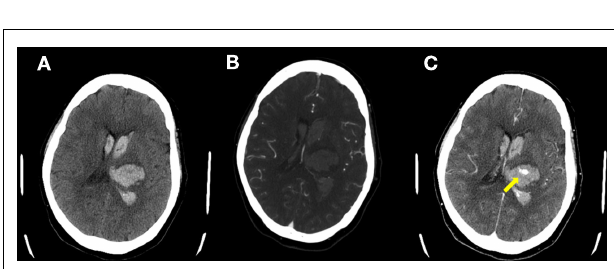
immediately following the CTA shows increase in contrast density from the CTA consistent with active contrast extravasation. (D) Unenhanced follow up CT at 6h demonstrates early hematoma expansion. A trace of intraventricular hemorrhage is present within the right trigone.